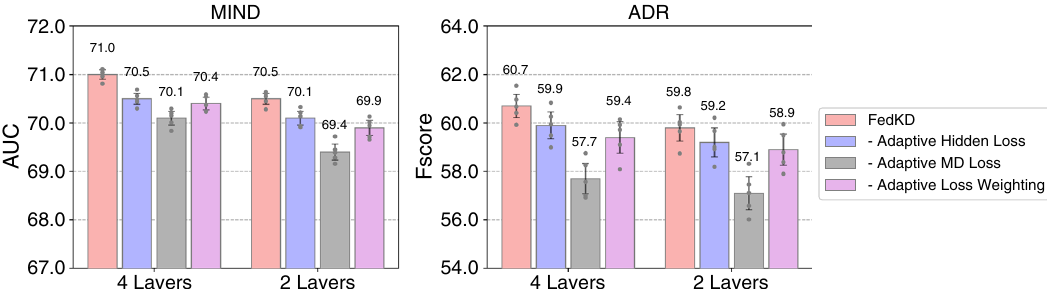
Fig. 3 Effectiveness of the adaptive mutual distillation techniques in FedKD. The mean results with 95% con fi dence intervals are presented ( n = 5 independent experiments). We compare the results by removing the adaptive hidden loss, adaptive mutual distillation loss or the adaptive loss weighting method from FedKD. Adaptive hidden loss: the distillation loss function that aims to transfer knowledge encoded by the hidden states and intermediate results of models, where the loss intensity is weighted by the prediction loss of mentee and mentor models. Adaptive MD loss: the distillation loss function that aims to distill knowledge from the output soft labels of models, and its intensity is also controlled by the prediction loss. Adaptive loss weighting: the mechanism that weights the two distillation losses based on the summation of cross-entropy losses of the mentor and mentee models. We fi nd the performance drops when either of them is removed, which veri fi es their contributions to federated model learning and distillation.